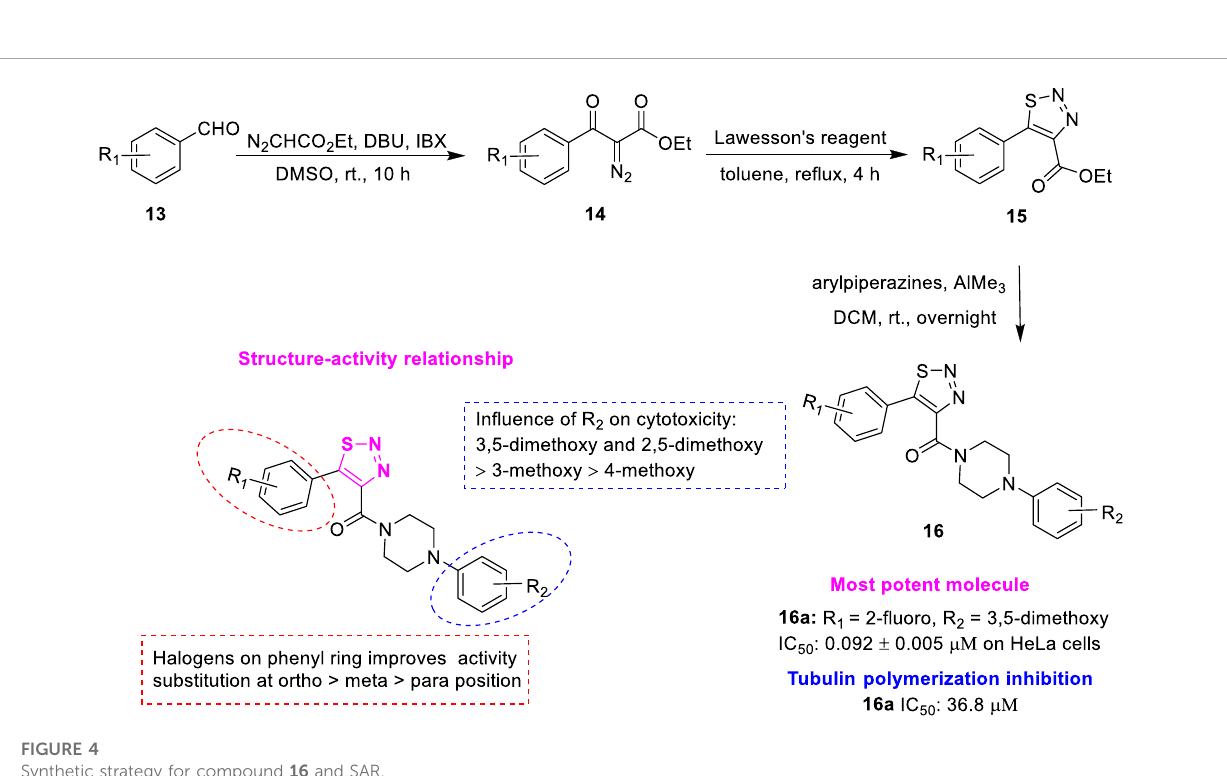
FIGURE 4 Synthetic strategy for compound 16 and